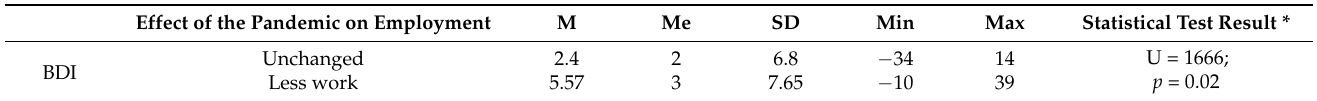
Table 4. The effect of the pandemic on the employment of healthcare professionals (HCPs) and the increase in their Beck depression inventory (BDI) scores between the two time